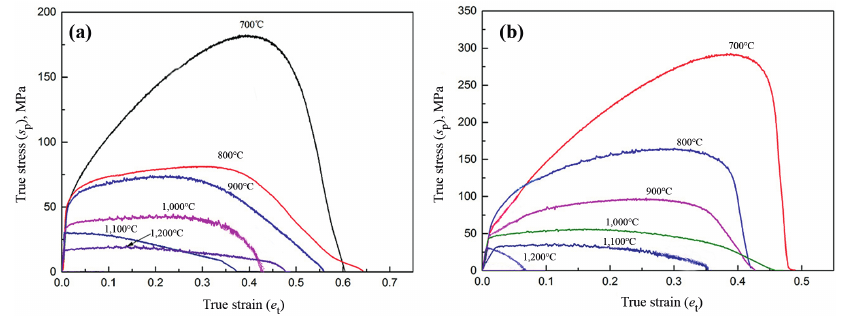
Figure 2: True stress-true strain curves as a function of temperature (a) steel 1, (b) steel 2.